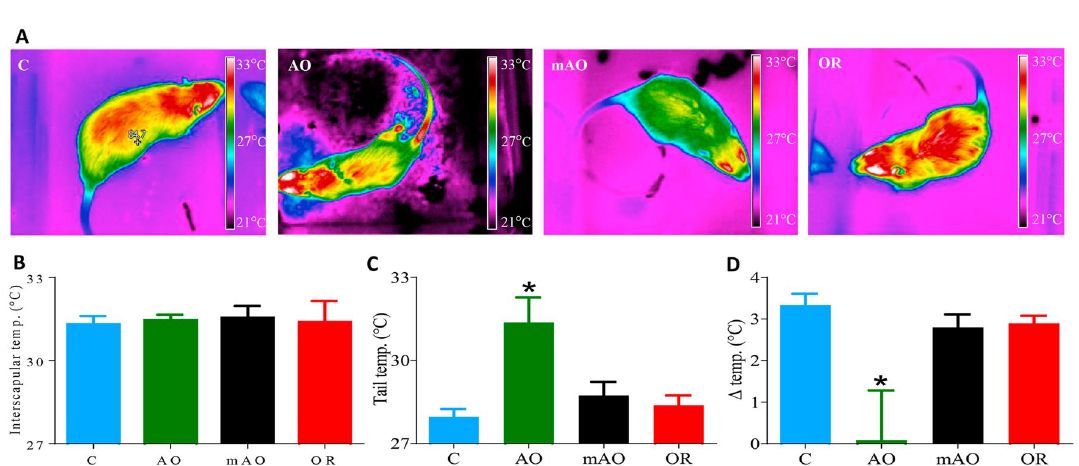
Figure 6. Thermography analysis: (A) Representative infrared images. (B) Interscapular temperature; (C) tail temperature measured 0.5 cm from the tail base; (D) the differences between interscapular and tail temperatures; blue—control; green—obstructive; black—mild obstructive; red—obstruction removal. * p < 0.01, C vs. AO or mAO group. In (D) , statistical differences were determined by a one-way